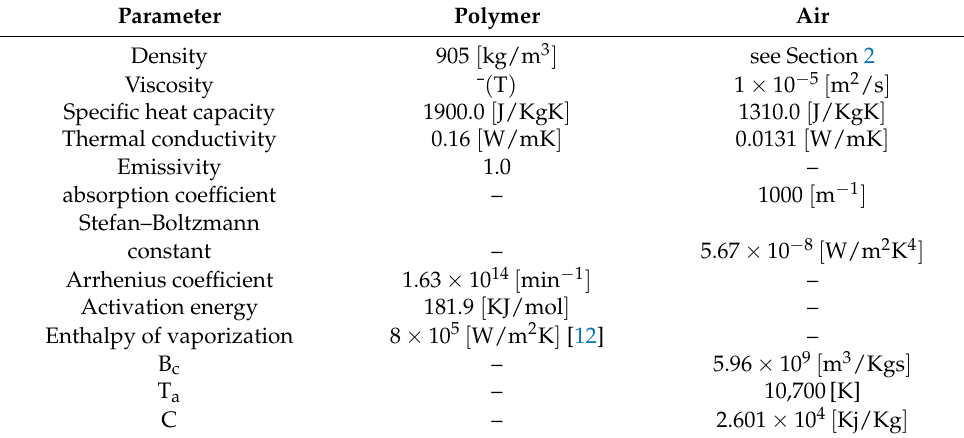
Table 1. Input parameters for the PFEM and Eulerian solvers.